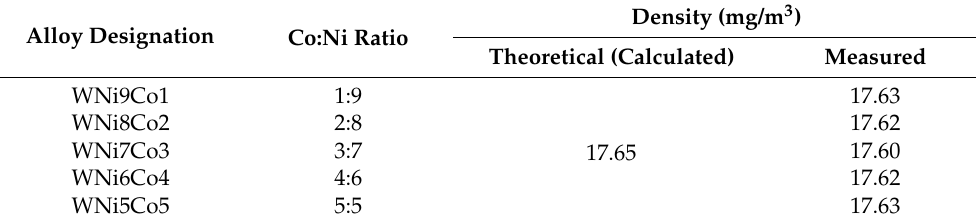
Table 3. Density of